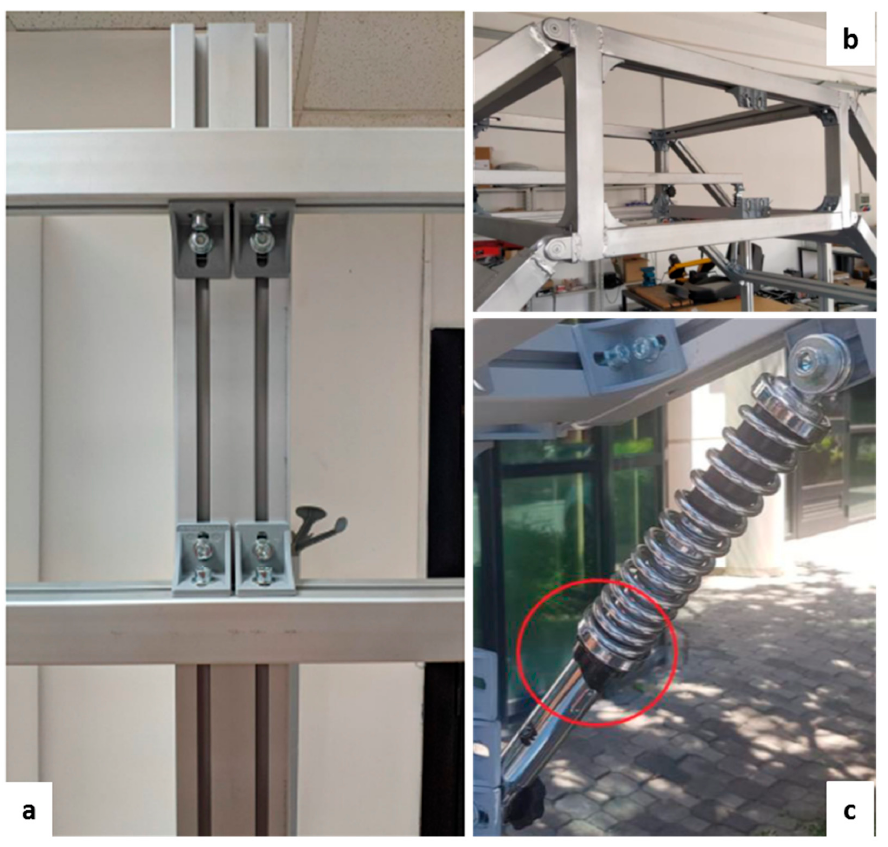
Figure 2. ( a ) Vertical seat for instrumentation; ( b ) crossbar with knobs for track adjustment; ( c ) ring nut for shock absorber preload.